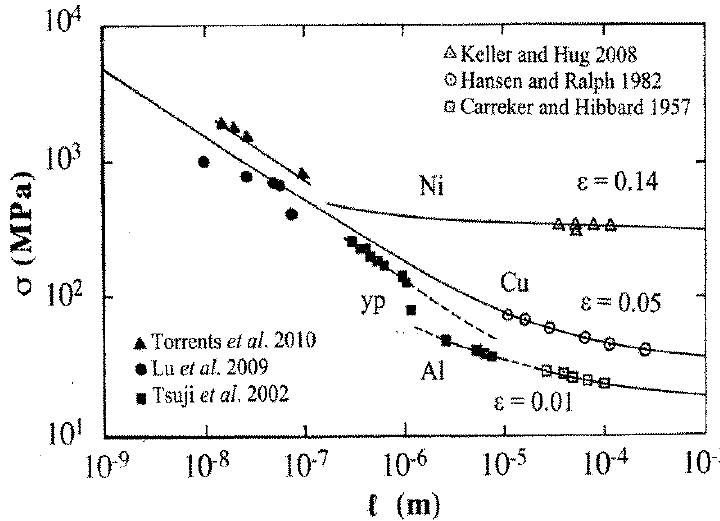
Figure 2. Comparison of Hall-Petch grain size dependent strengthening results at conventional and nano-polycrystalline grain sizes for Al, Cu, and Ni materials; the referenced data are given in Reference [5].